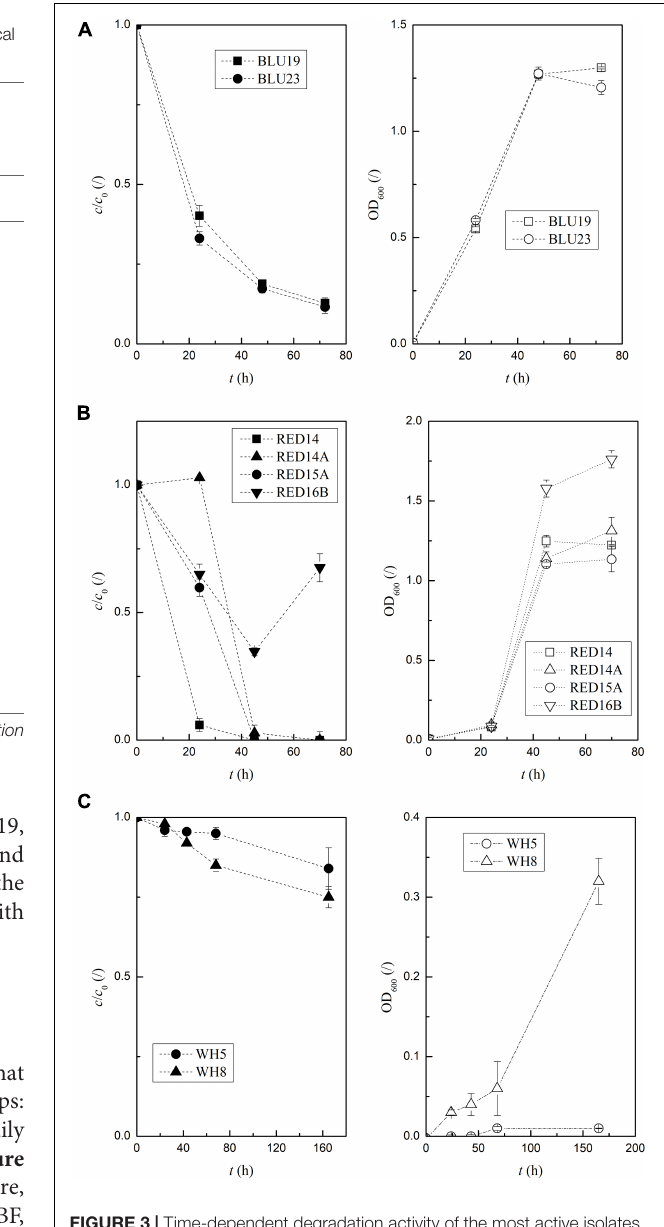
FIGURE 3 | Time-dependent degradation activity of the most active isolates for red, blue, and whitener incubated up to 165 h at 25 ◦ C. The error bars indicate the standard errors of triplicates; low values of c / c 0 indicate a high degradation activity; c / c 0 are full and OD 600 empty symbols. (A) BLU19 and BLU23 in NB+10 mg/L blue. (B) RED14, RED16B, RED14A, and RED15A in NB+13 mg/L red. (C) WH5 and WH8 in M9 Glc +0.5 g/L